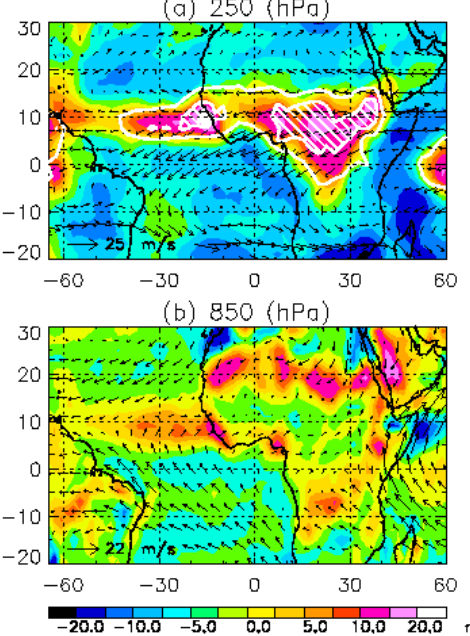
Fig. 1. August 2006 ECMWF winds. Black arrows represent hor- izontal winds and color contours vertical winds (a) 250hPa (b) 850hPa. White contours indicate deep convection (OLR contours 240 and 215W/m 2 , with values below 215 hatched